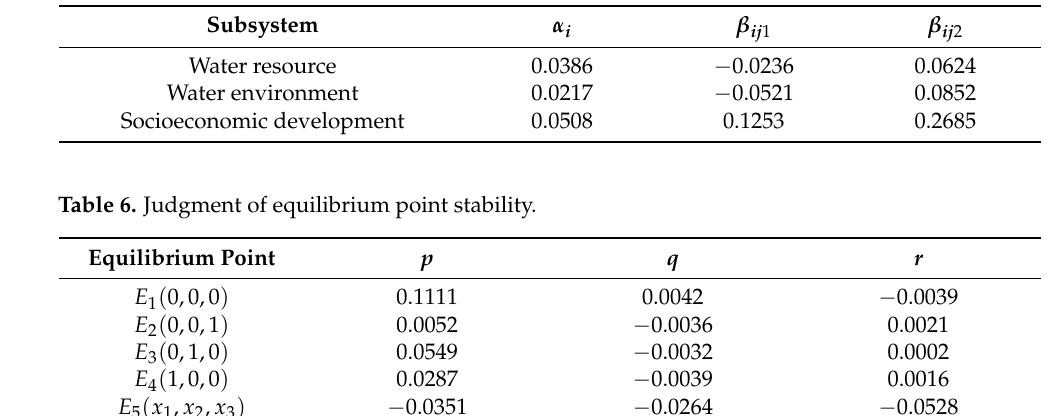
Table 5. The parameter estimation results.